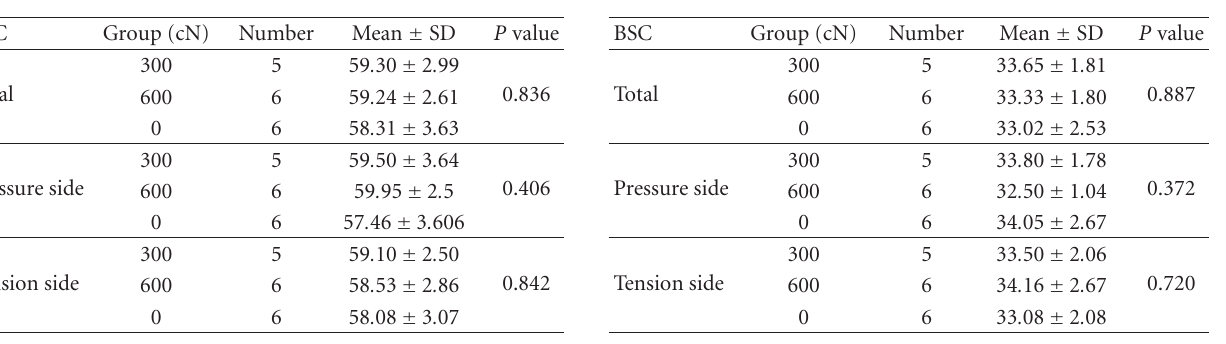
Table 3: Statistical indices for woven bone around mini-screw within 2mm at pressure side and at tension